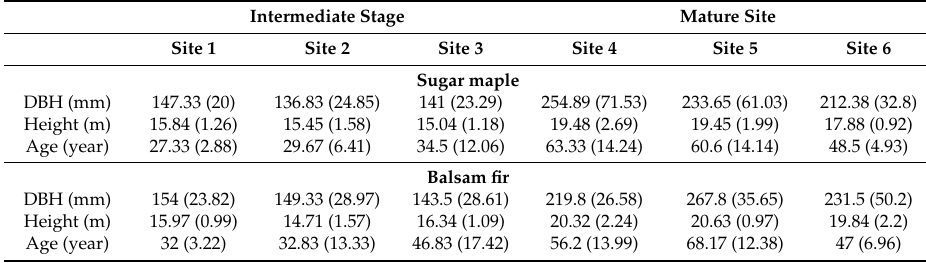
Table 1. Tree characteristics by site (pure and mixed stands). Mean (standard